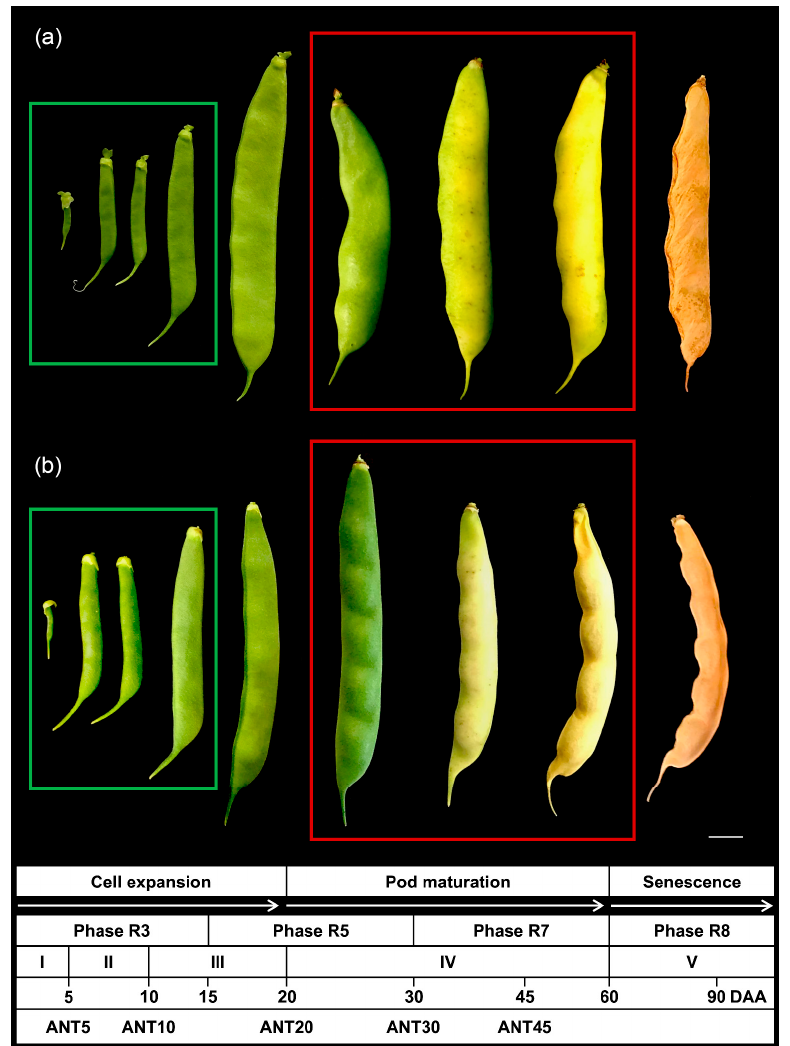
Figure 1. Growth characteristics of pods harvested at different time points after anthesis (DAA) during development of the cultivated breeding line PMB0225 ( a ) and the weedy-form PHA1037 ( b ). The key phases and stages of pod development are assigned according to [32,33] as: R3 = first pod larger than 2.5 cm; R5 = beginning of rapid seed growth; R7 = physiological maturity; and R8 = harvest maturity; Stages I (0 − 5 DAA) = initial exponential growth; II (5 − 10 DAA) = linear growth; III (10 − 20 DAA) = cessation of pod elongation; IV (20 − 60 DAA) = maturation; and V (60 − 90 DAA) = senescence. Additionally, taking as reference the day of anthesis (ANT), sub-stages of pod development used for transcriptomic analysis were labeled as ANT5, ANT10, ANT20, ANT30, and ANT45. ANT5 and ANT10 were considered as immature stages (green rectangle), whereas ANT20, ANT30, and ANT45 were considered as mature stages (red rectangle). Scale bar = 1 cm.